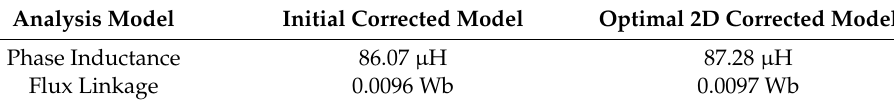
Table 3. Inductance and flux linkage of each analysis model.